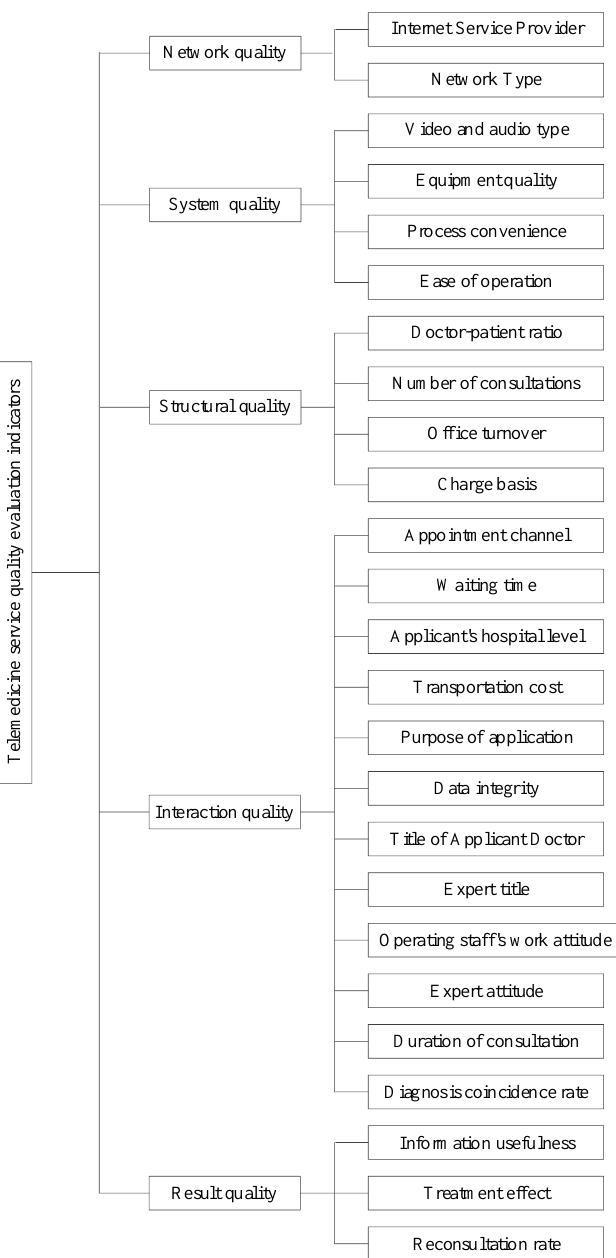
Figure 2 . Initial evaluation index of telemedicine service